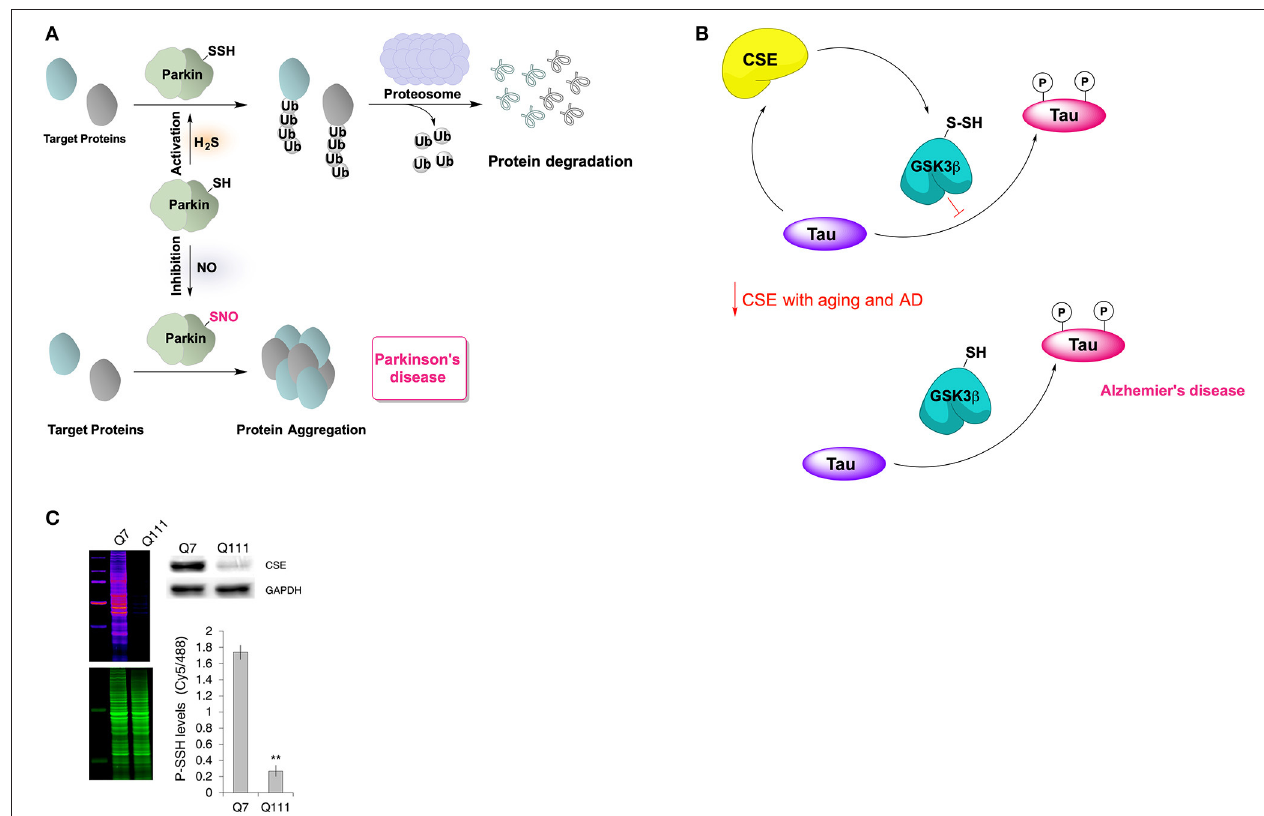
FIGURE 5 | Neuroprotective effects of protein persulfidation. (A) Schematic representation of the regulatory role of H 2 S on catalytic activity of parkin. In healthy subjects, the E3 ubiquitin ligase, Parkin is persulfidated, which increases its enzymatic activity. This leads to ubiquitylation of diverse substrates, such as alpha-synuclein (a component of the Lewy bodies found in Parkinson’s disease), and their subsequent proteasomal degradation. In patients with Parkinson’s disease, parkin is S-nitrosylated with greatly decreased catalytic activity, resulting in protein aggregation, accumulation of toxic proteins and cell death. (B) Cystathionine gamma lyase (CSE) interacts with tau protein which results in allosteric modulation of its activity resulting in higher H 2 S production and consequently persulfidation of glycogen synthase kinase 3 beta (GSK3 β ). Persulfidation of GSK3 β inhibits its kinase activity resulting in less tau phosphorylation. With aging, or in Alzheimer’s disease, CSE levels decrease making the GSK3 β predominantly present in thiolate form which results in increased tau phosphorylation and aggregation. (C) Protein persulfidation levels are almost entirely diminished in striatal cells expressing huntingtin with 111 polyQ repeats. This decrease of PSSH levels is caused by a big reduction in CSE levels. Taken from Zivanovic et al.